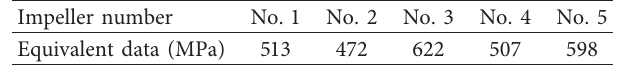
Table 5: Equivalent data for fatigue strength after transformation.